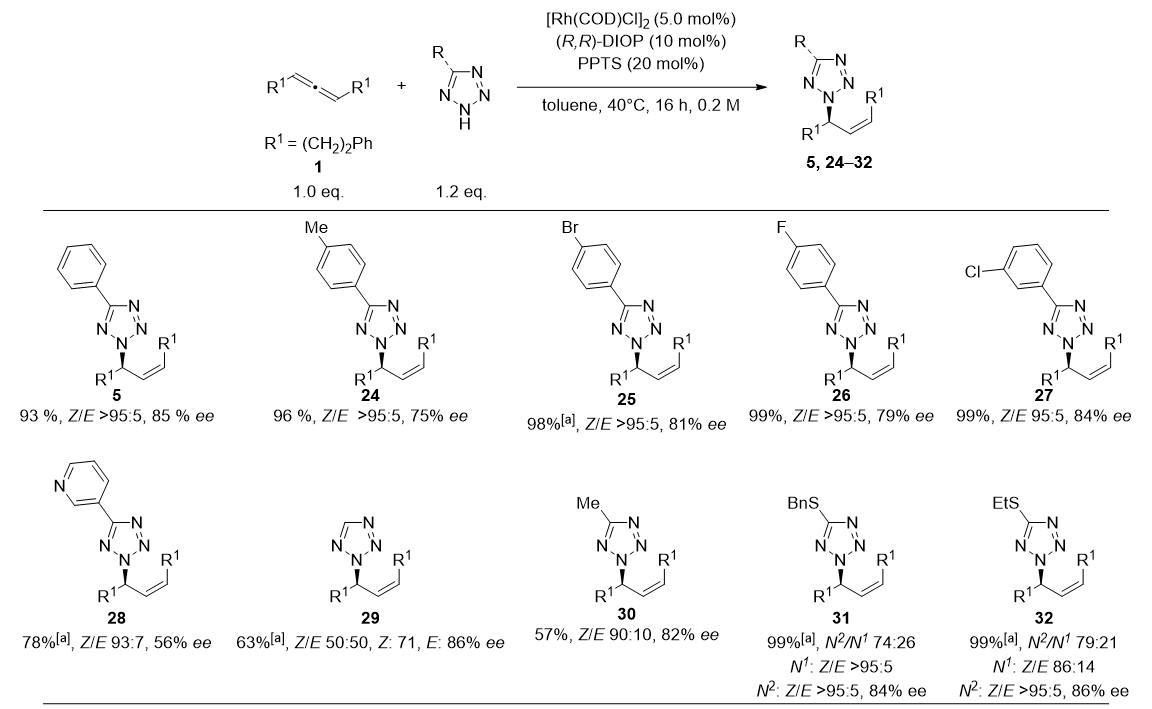
Figure 4. Scope of the addition of Tetrazoles to rac-1,7-diphenyl-hepta-3,4-diene. ( 1 ) Reactions were performed at 0.25 mmol scale. Cumulative yield for all isolated isomers. Z/E -selectivities were determined by 1 H-NMR. Enantioselectivities were determined by HPLC analysis using a chiral stationary phase. Unless specified, ee -values refer to main-stereoisomer of the main-regioisomer. Unless specified full N 2 -selectivity was obtained. [a] Reaction was performed at 60 °C. Halogen-substituted phenyltetrazoles were coupled in nearly quantitative yields ( 25 – 27 ). Tetrazoles containing thioethers ( 31 , 32 ) were the only ones to yield products with reduced N 2 / N 1 -regioselectivity (about 3:1); however, maintaining quantitative yield and consistently high Z / E - and enantioselectivity. Eventually, we subjected several allenes to the reaction with 5-phenyl-tetrazole ( 4 ) (Figure 5).